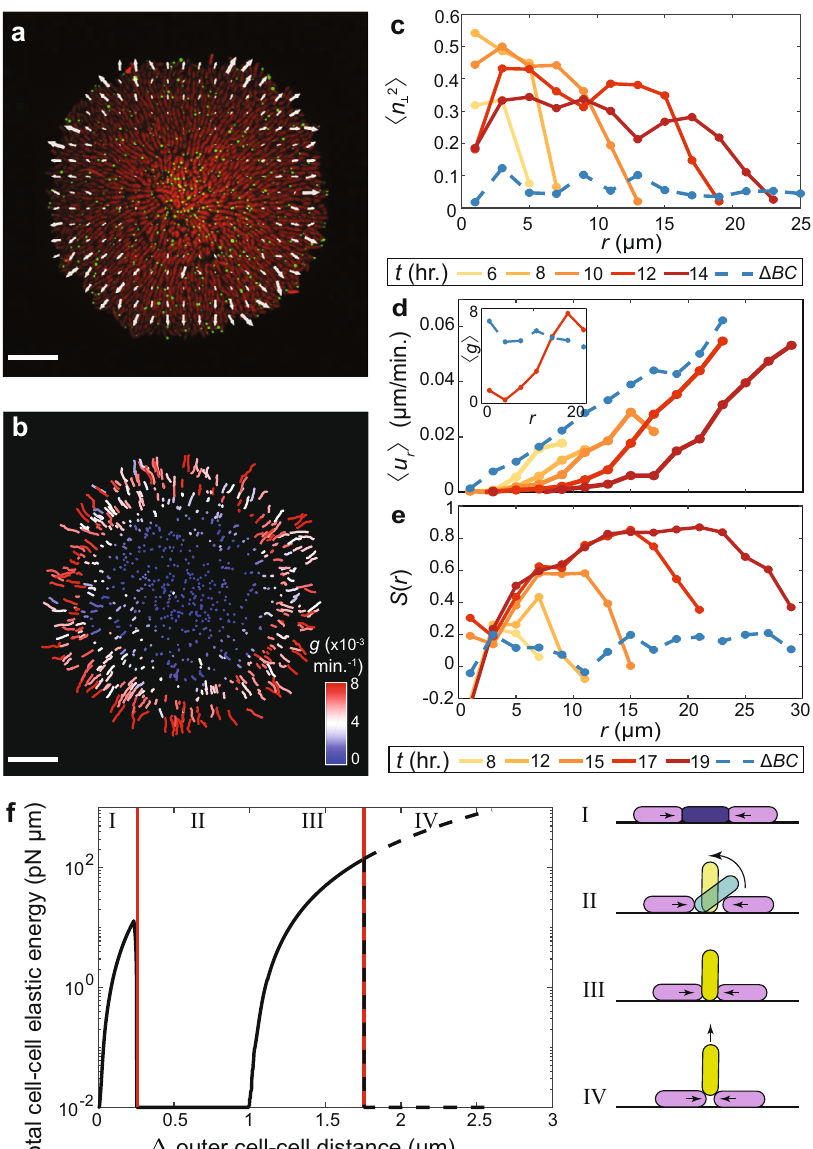
Fig. 2 Growth-induced cellular fl ow and surface anchoring jointly lead to aster formation in bio fi lms. a Raw image of the basal layer of a bio fi lm consisting of cells constitutively expressing mScarlet-I cytosolically and mNeonGreen-labeled puncta. Overlain is the velocity fi eld measured from puncta (cid:1) (cid:3) = r in a trajectories. b Puncta trajectories colored by the apparent in-plane growth rate g . The apparent in-plane growth rate is calculated as g r ð Þ ¼ ∂ r ru r (cid:4) (cid:5) neighborhood around each cell. Scale bars, 10 µ m. c Azimuthally averaged degree of verticalization n 2 ? as a function of distance r from the center, in the basal layer. This quanti fi cation was performed in cells expressing mNeonGreen cytosolically, which allows for more accurate quanti fi cation of n ? : d , e (cid:4) (cid:5) Azimuthally averaged radial velocity u r (Inset: apparent in-plane growth rate g h i ´ 10 (cid:3) 3 min : (cid:3) 1 ) ( d ) and radial order parameter S ( e ) as a function of distance r from the center, in the basal layer. In c – e , the dashed blue lines denote results from the nonadherent mutant. f Results of a reduced problem showing the strain energy due to cell-to-cell contacts in a cell as it is squeezed by its neighbors (black line). The dashed red lines denote the results from stability analyses (Supplementary Information Section 3). Upon increasing compression, the central cell evolves through four phases, which are given schematically. Source data are provided as a Source Data fi